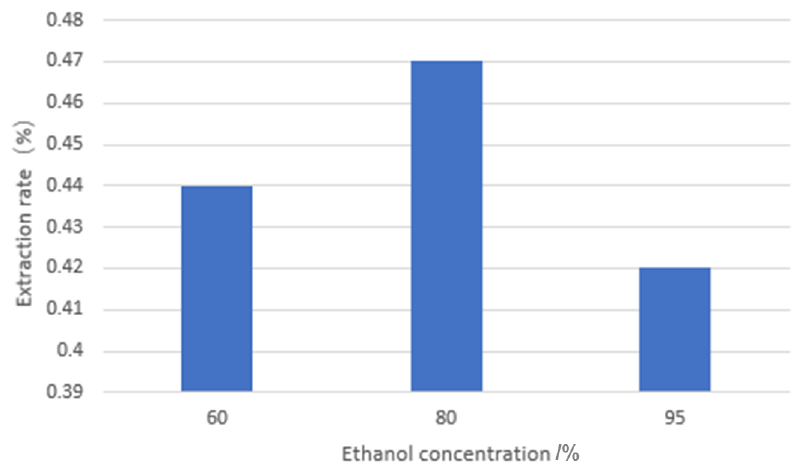
Figure 5. Effect of the entrainer concentration on the extraction rate.